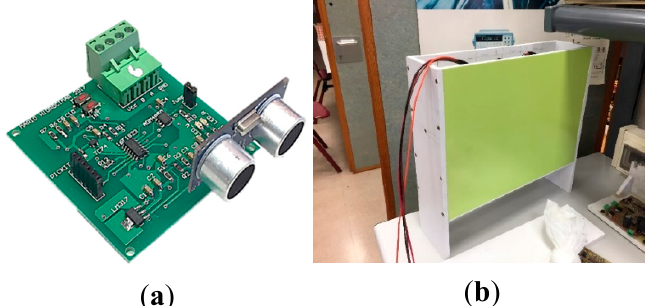
Figure 2. ( a ). Ultrasonic sensor; ( b ) The Ultrasonic height measuring station will estimate the water level by calculating the mean of the data provided by three ultrasonic sensors.